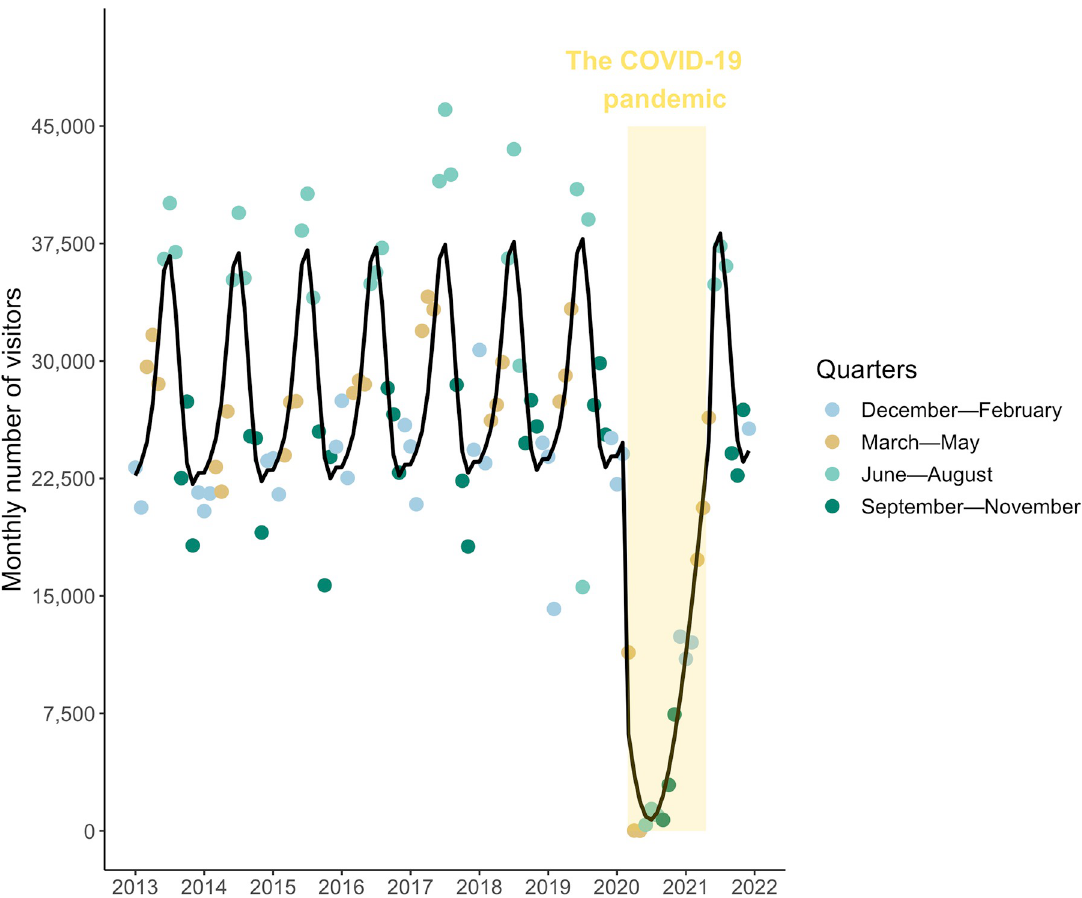
Fig 2. Monthly variation in the number of people visiting Molokini since 2013. Circles show monthly counts of people at Molokini and are colored by quarters (q) that each corresponds to a 3-month period. The black line is the result of the GAM model. The yellow box denotes the period of travel restrictions associated with the COVID-19 pandemic (from March 2020 to May 2021).